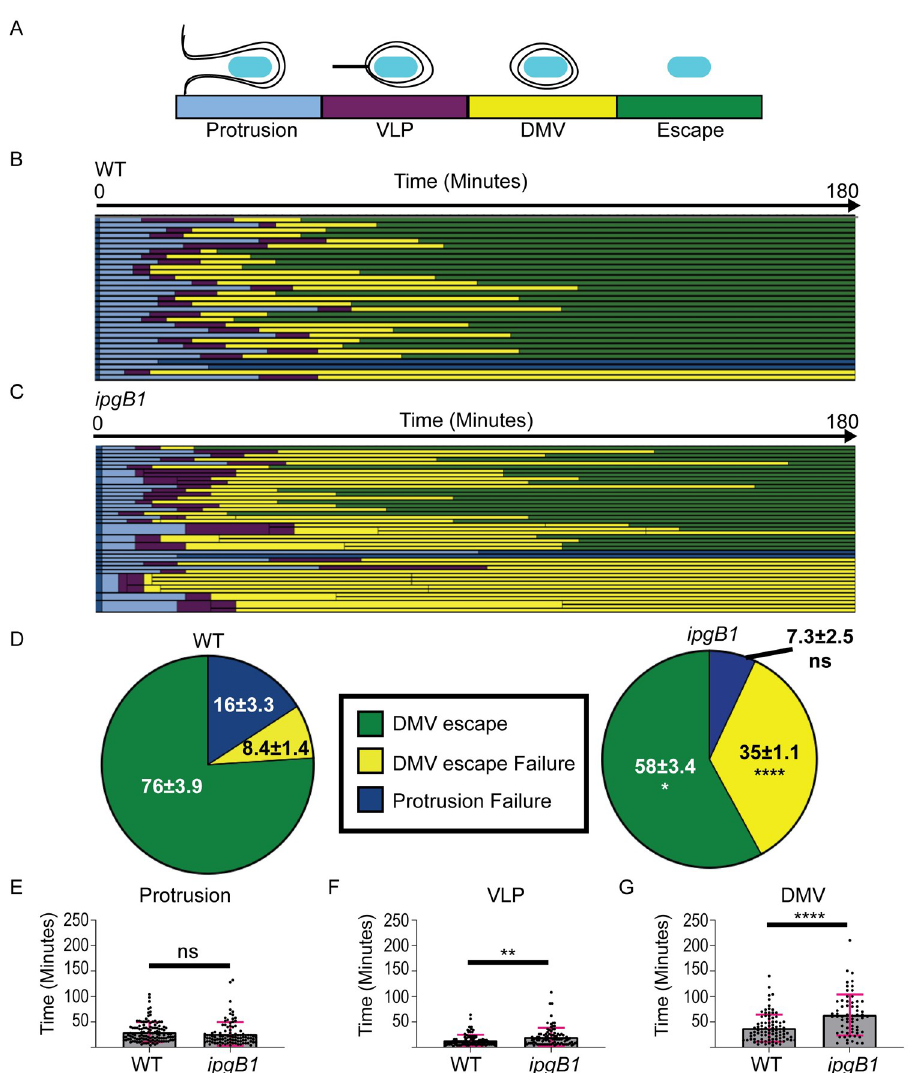
Fig 2. IpgB1 is required for efficient DMV escape. (A) Schematic depicting the stage and corresponding color code of spread progression (B and C) Representative tracking analysis of (B) wild type or (C) ipgB1 CFP-expressing S . flexneri in HT-29 cells expressing plasma membrane-targeted YFP. Each bar represents the tracking of a single bacterium over 180 minutes. For ipgB1 , the thicker bars indicate when bacteria divided and branched during spreading. At least 30 bacteria were tracked for each strain per biological replicate. (D) Graphs showing the proportions of fates of tracked bacteria from 4 biological replicates. Standard deviations of the means are indicated. Two-way ANOVA with Sidak’s multiple comparisons was performed; ns, not significant; � , p < 0.05; ���� , p < 0.0001. Time spent in protrusions (E), VLPs (F), or DMVs (G) is shown for all tracked bacteria. Each dot represents a single bacterium and the grey bars show the mean of all tracked bacteria from four biological replicates. Error bars indicate standard deviation. Unpaired two-tailed t-tests were performed; ns, not significant; �� , p < 0.005; ���� , p < 0.0001.